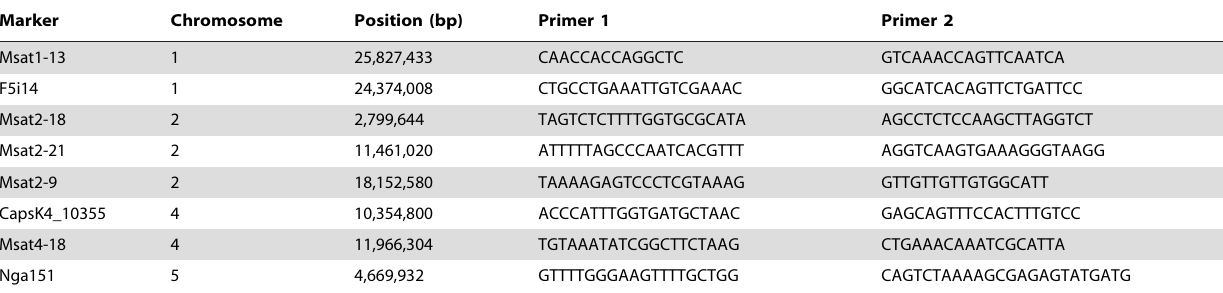
Table 2. Genetic markers.